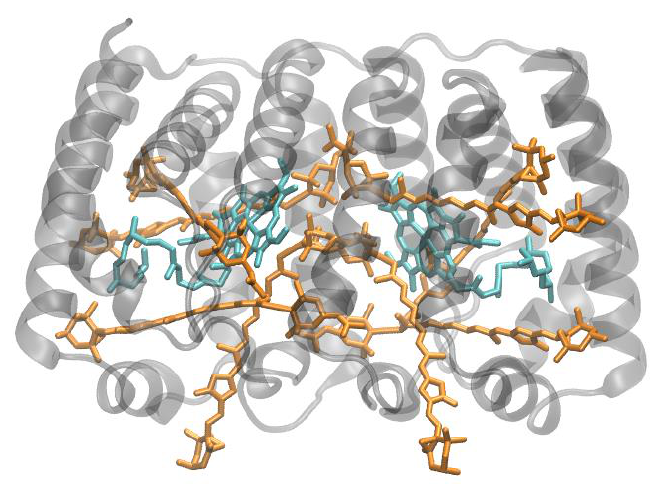
Figure 6. Structure of the trimeric peridin-chlorophyll a -protein complex (PCP) from Amphidinium carterae at 2.0 Å resolution, PDB entry 1PPR [62]. The protein backbone is shown in grey. Chlorophylls a are shown in cyan, peridinins in orange.